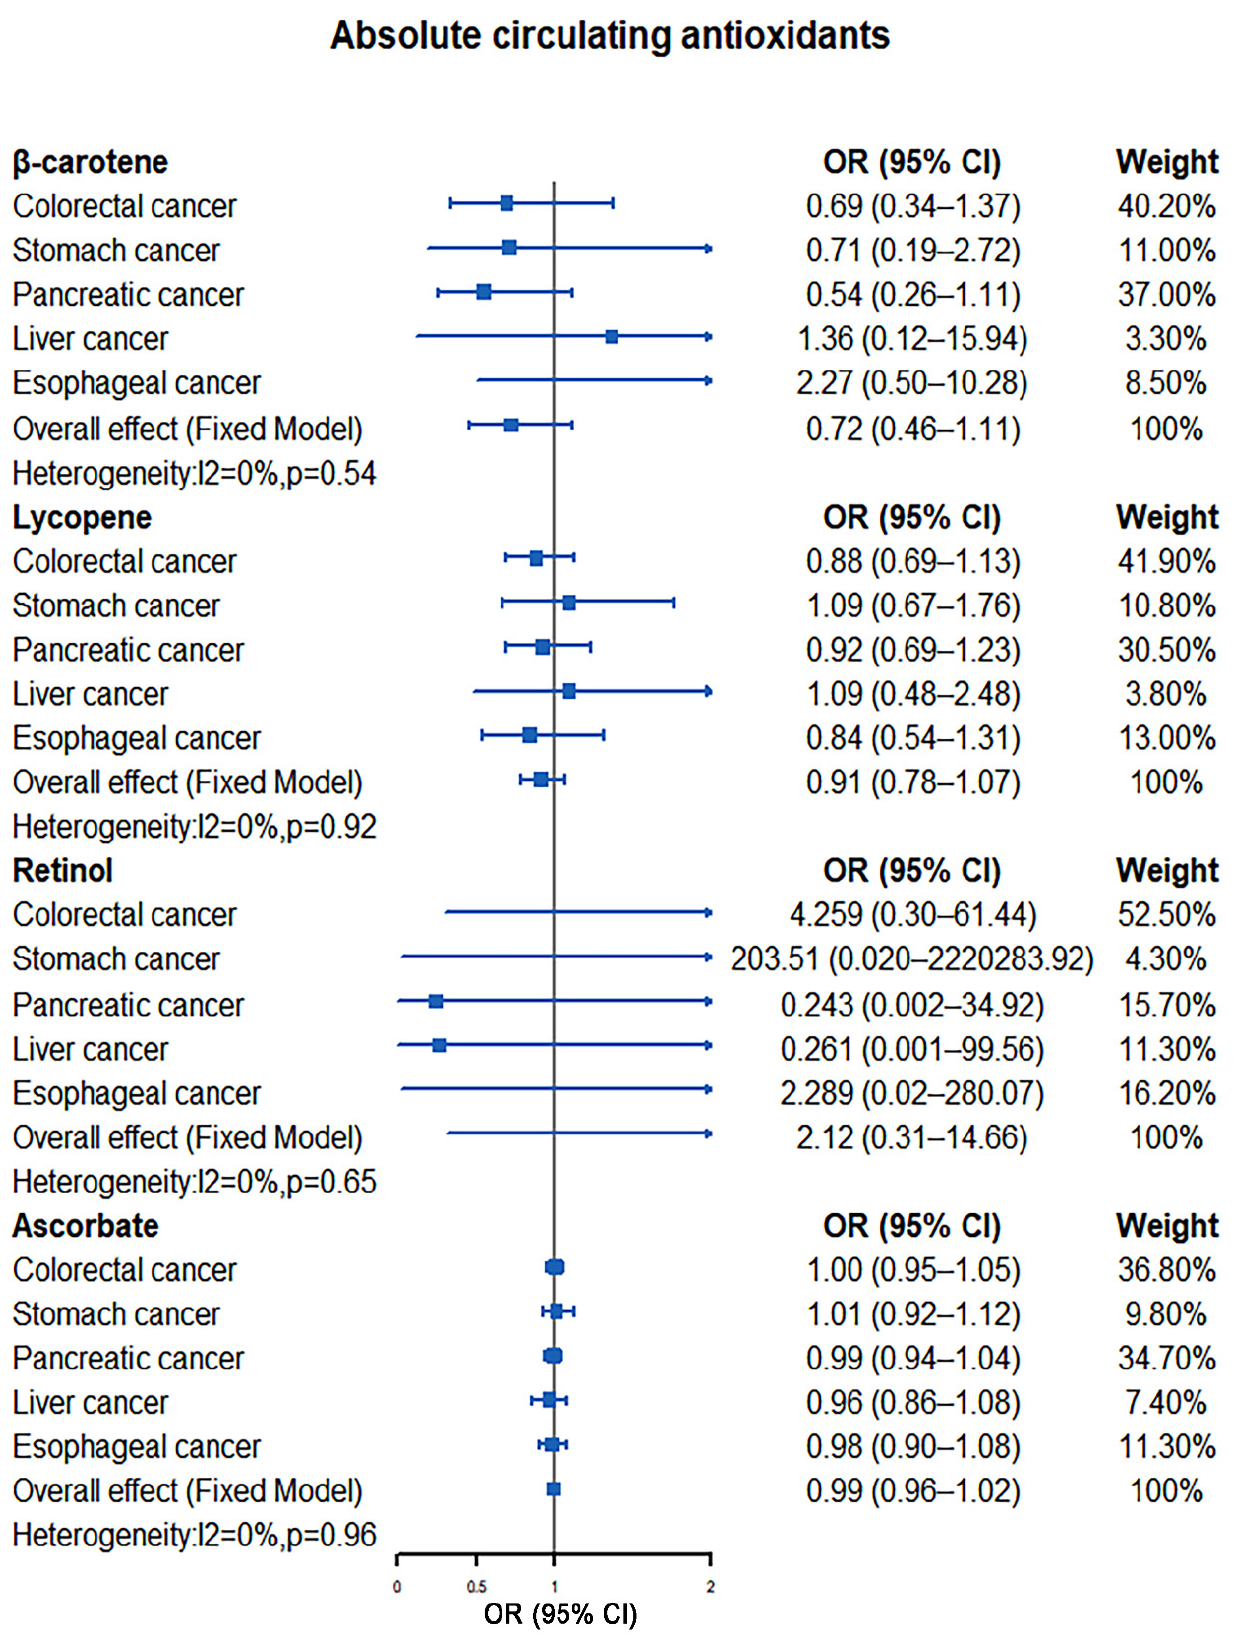
Figure 2. Causal association between absolute circulating antioxidants with digestive system tu- mors.